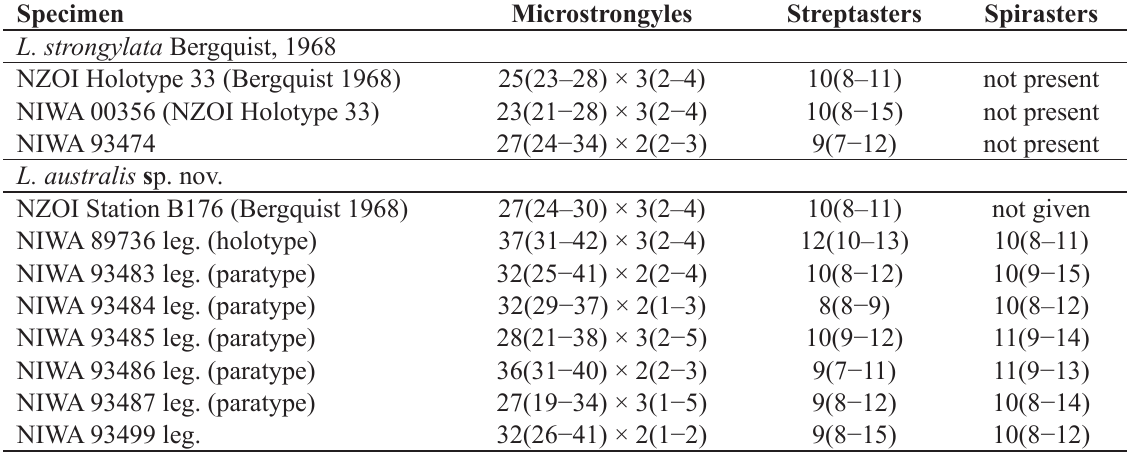
Table 2. Microscleres and dimensions (µm) of Lamellomorpha strongylata Bergquist, 1968 and L. australis Kelly & Cárdenas sp. nov., given as length [mean (min.–max.)] × width [mean (min.– max.)], n = 10–17 unless stated